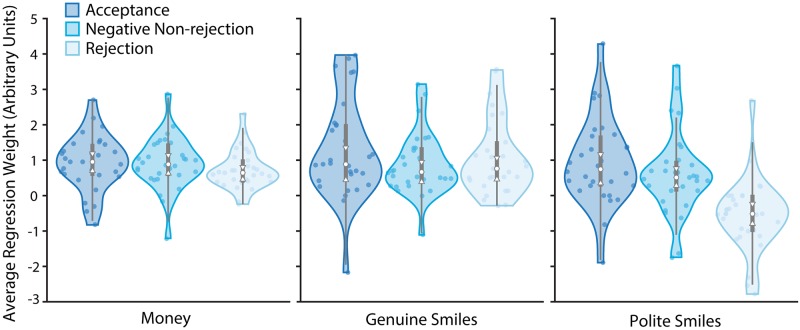
Regression analyses.Violin plots of regression weights estimated by the logistic model, indicating the degree to which money, genuine smiles, and polite smiles influenced choice behaviour across conditions. The grey-shaded central boxes show the inter-quartile range and the whiskers show the 95th percentile of the data distribution. Plot upper and lower boundaries show the full range of the data. The white dots depict the distribution medians while the notches show the 95% confidence interval on the medians. Individual data points are marked with coloured dots on each plot.